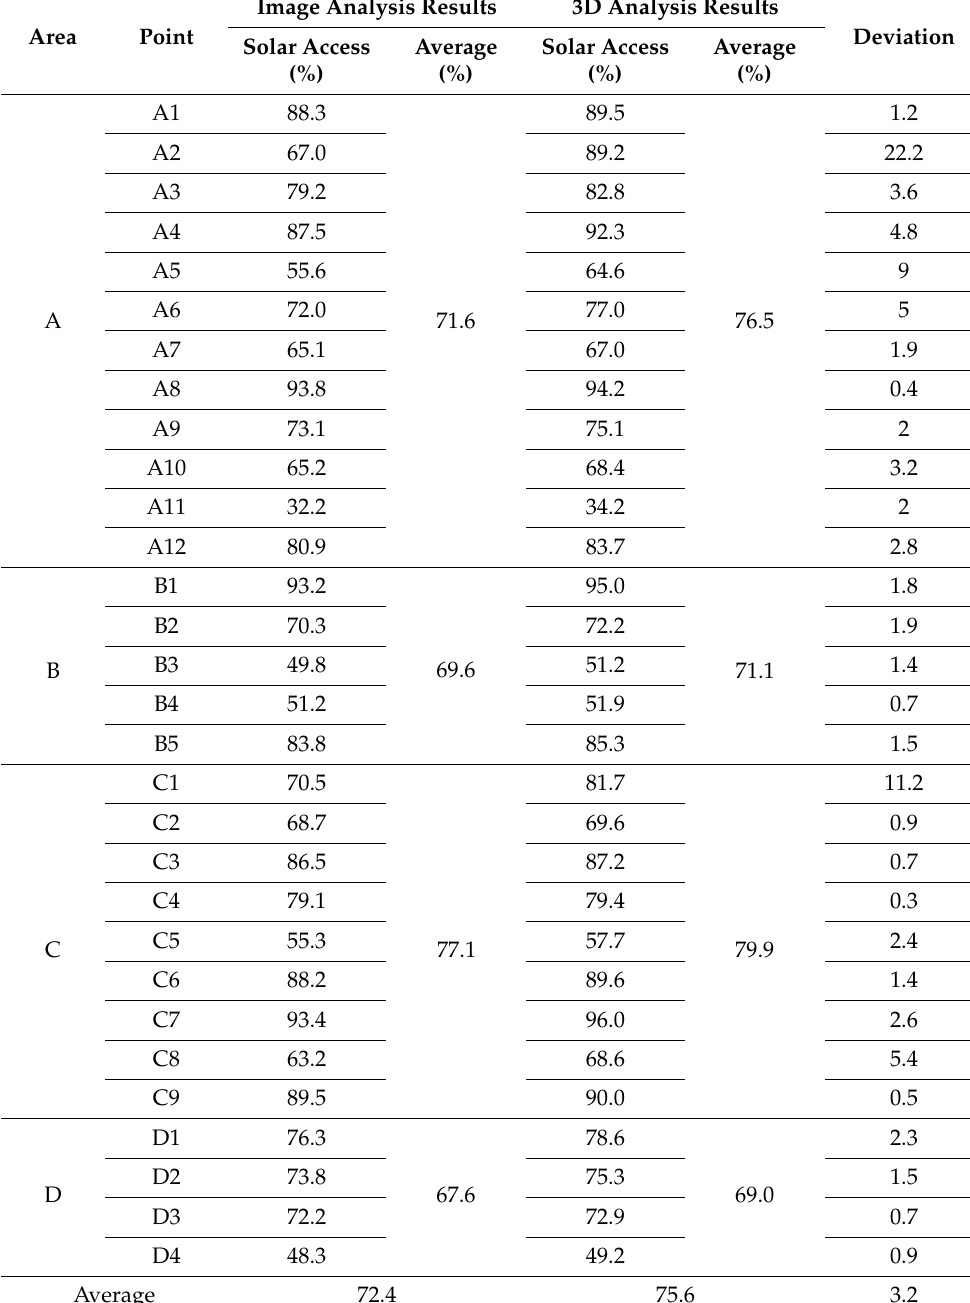
Table 1. Comparison of solar access results of image analysis and 3D analysis for 30 points. Image Analysis Results 3D Analysis Results Area Point